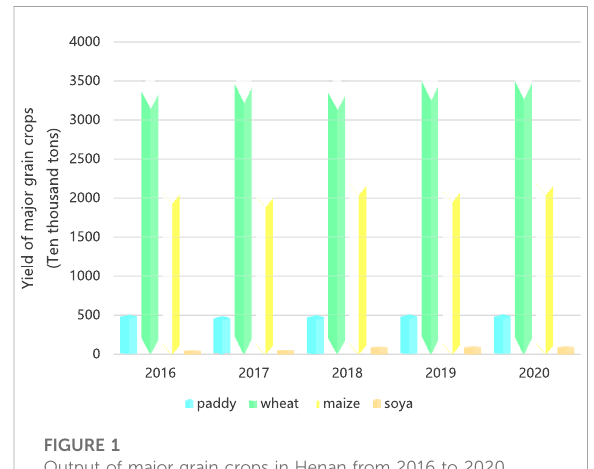
FIGURE 1 Output of major grain crops in Henan from 2016 to